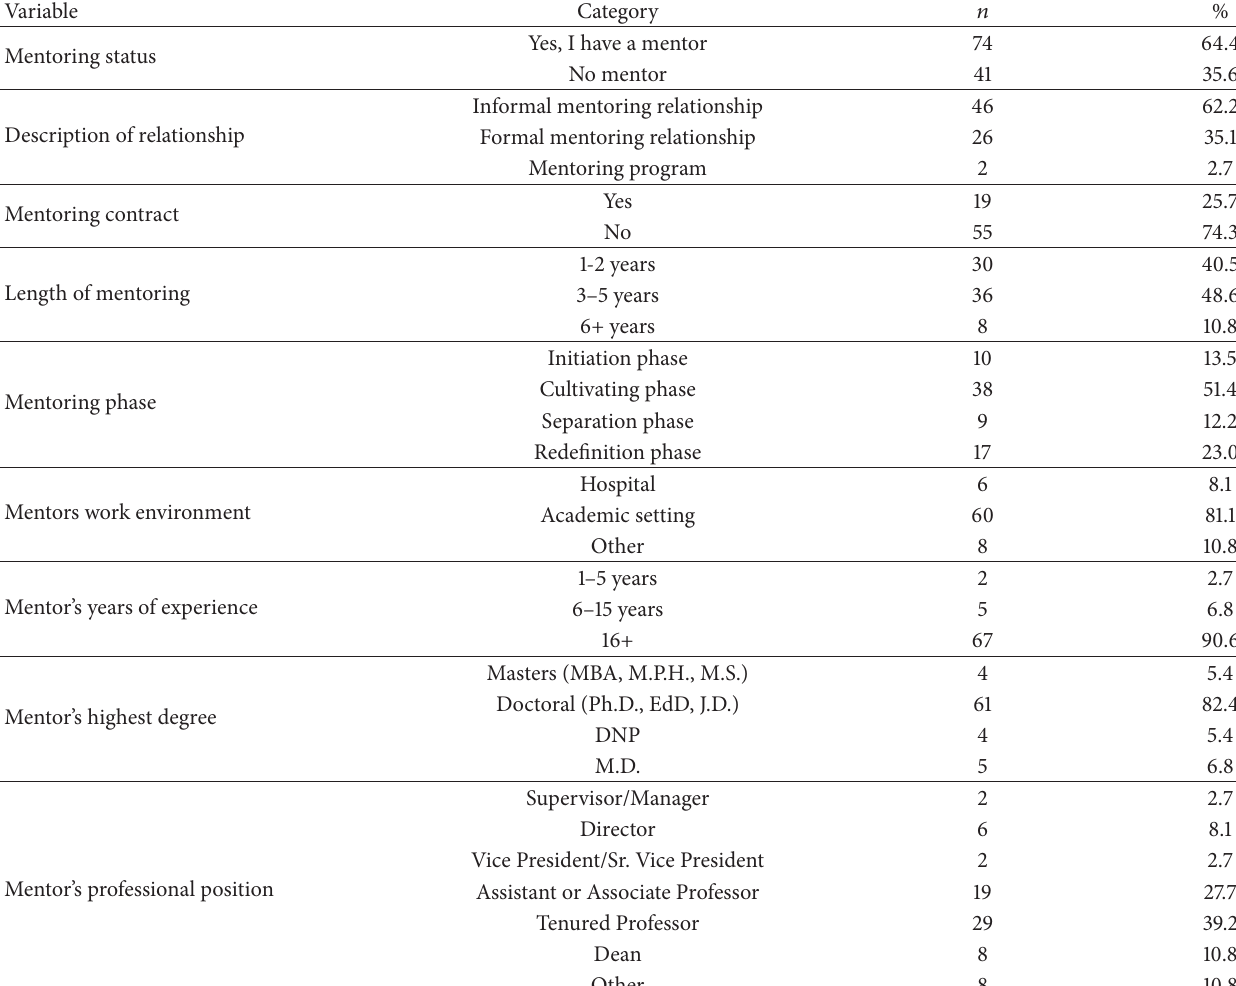
Table 2: Mentoring demographics ( 𝑁 = 115 ).